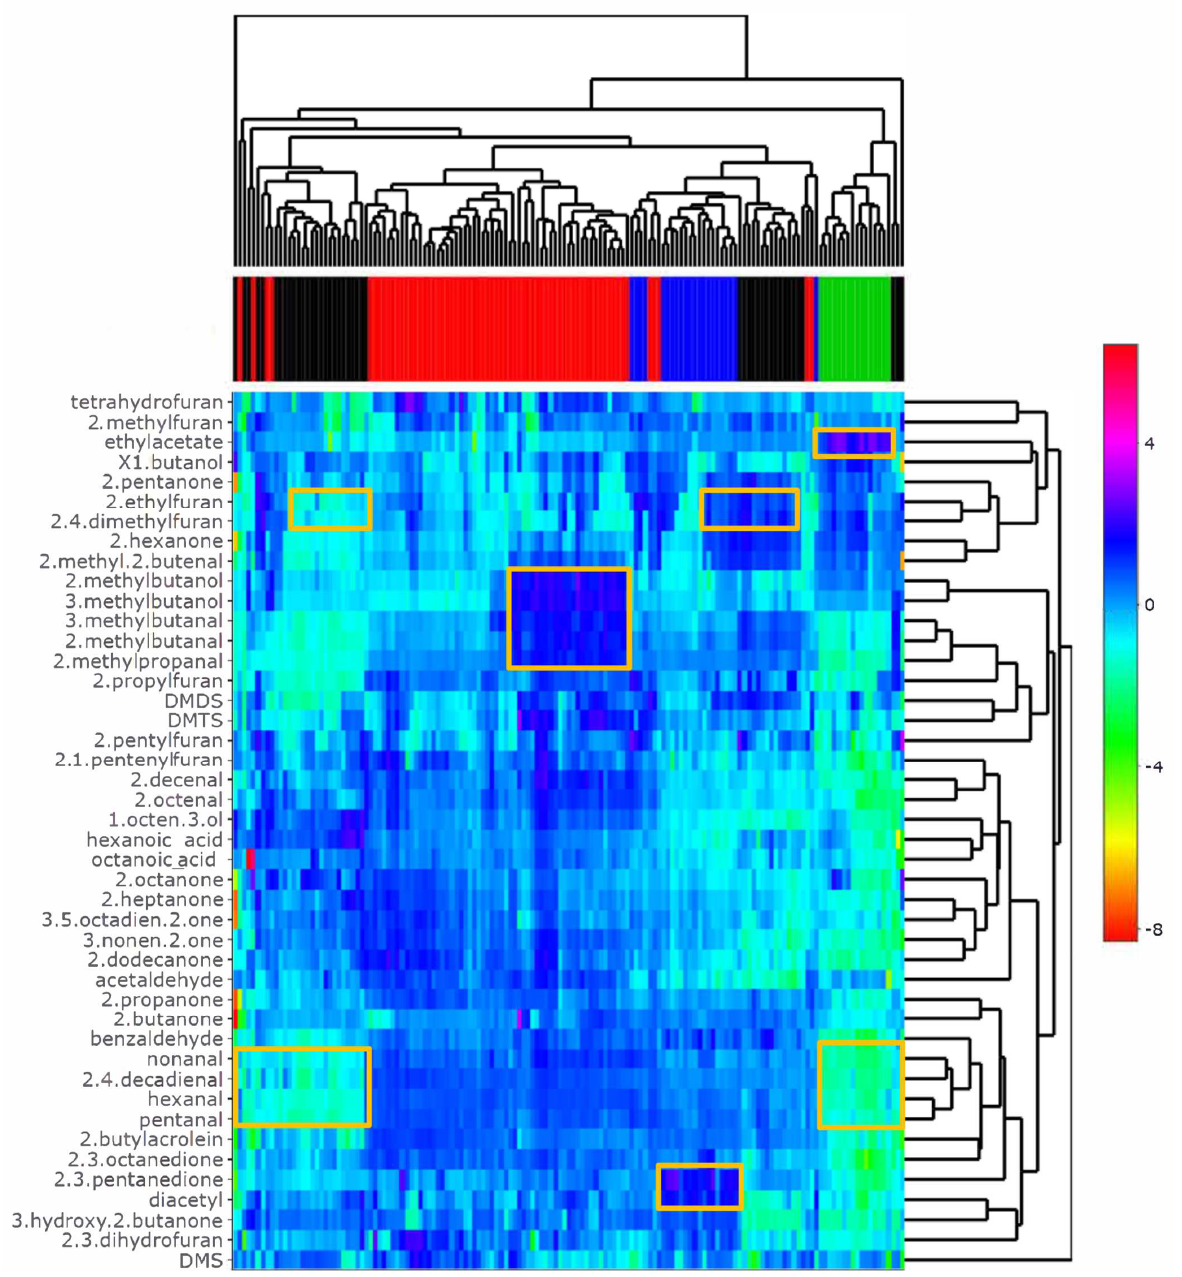
Figure 3. Heatmap of volatile compounds identified after incubation of strains in a mixed emulsion of pea, chickpea, and mung bean protein isolates blended with coconut oil supplemented with 0.5% glucose. Each branch on the dendrogram at the top represents one strain and the top colours in the heatmap indicate the genus of the bacteria, Lactococcus (red), Lactobacillus (black), Streptococcus (blue), and Leuconostoc (green). The data were corrected for the blank and transformed to a log10 scale before preparing the heatmap.